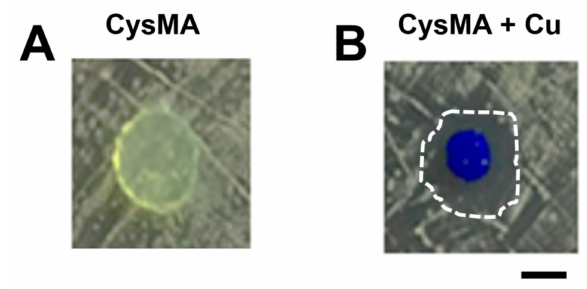
Figure 6. Antibacterial activity of copper released from hydrogels. The antibacterial activities of hydrogels without ( A ) or with ( B ) copper ions were examined on agar plates inoculated with MRSA, USA300, using inhibition zone (dashed circle) tests. Bar = 0.5